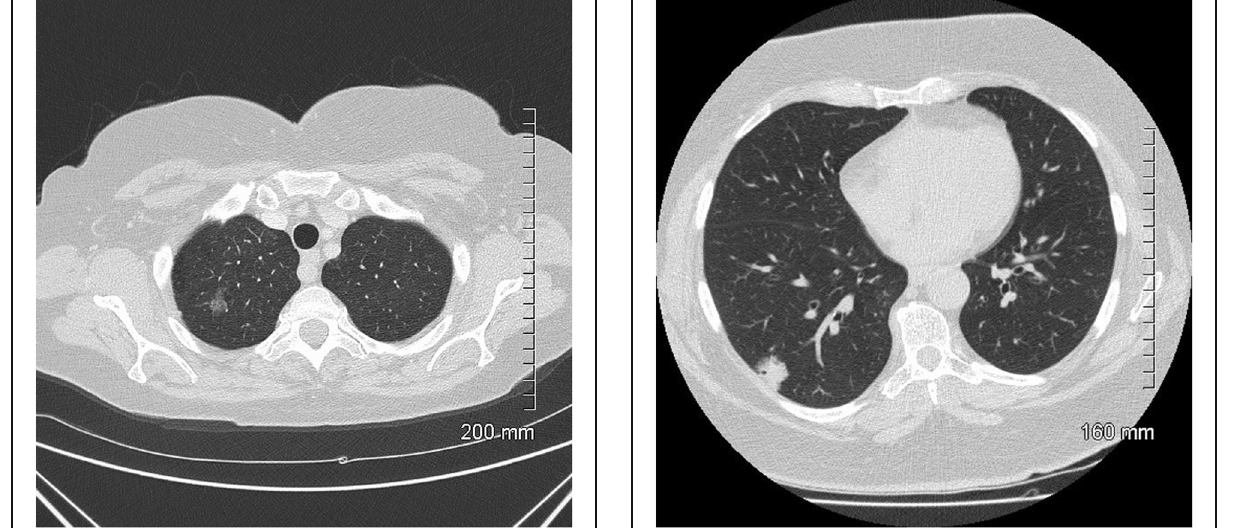
Fig. 11 Favourable prognostic indicators: small size (< 2 cm). The pure ground glass nodule in the right upper lobe measures 10 mm. AIS